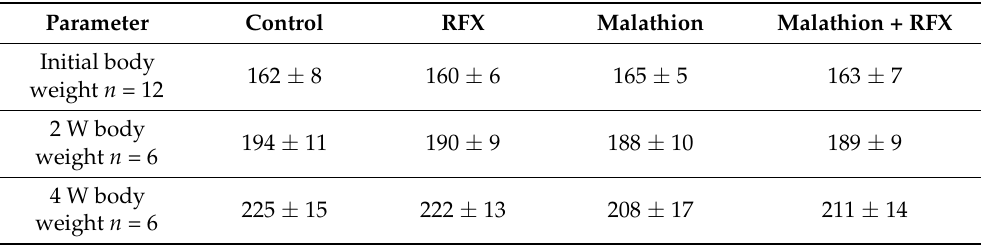
Table 2. Body weight of different treatment groups exposed to malathion with or without rifax- imin (RFX). Parameter Control RFX Initial